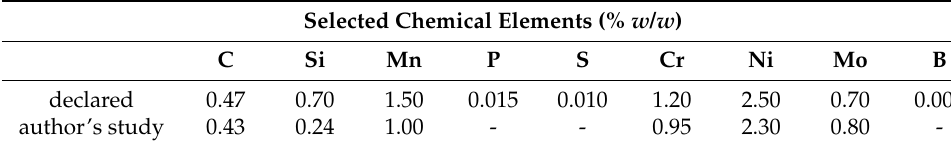
Table 7. The chemical composition of Hardox 600 steel.